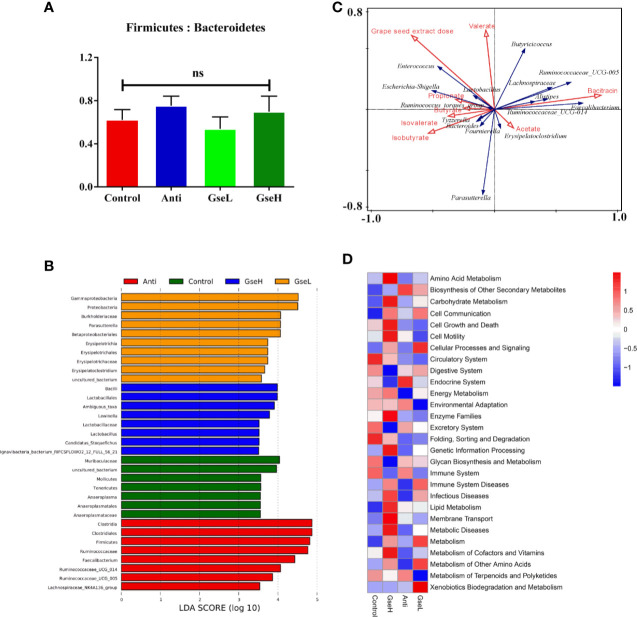
Summary of microbial communities in the cecal contents of broilers on day 21 (A). is the Firmicutes/Bacteroidetes (B). represents the LEfSe analysis (C). is the RDA (D). provides the PICRUSt analysis. N = 8 per treatment group. ns, not significant.